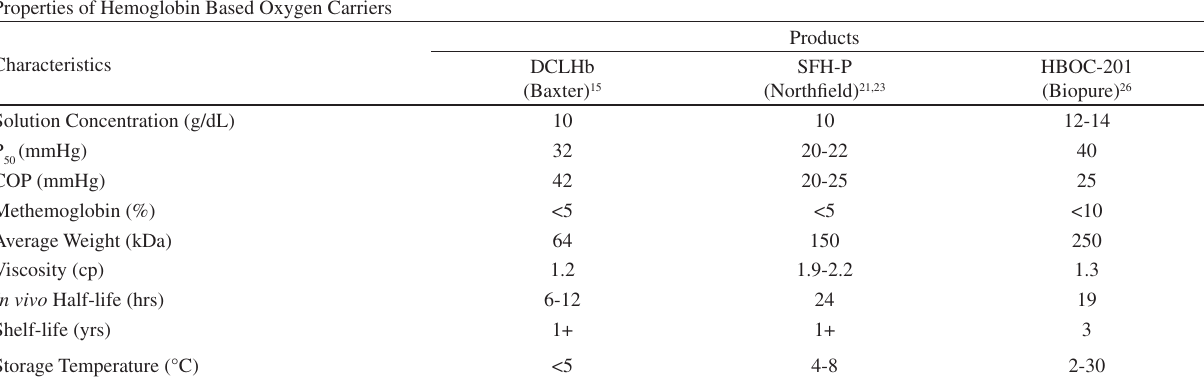
Table 1 - Properties of hemoglobin based oxygen carriers Properties of Hemoglobin Based Oxygen